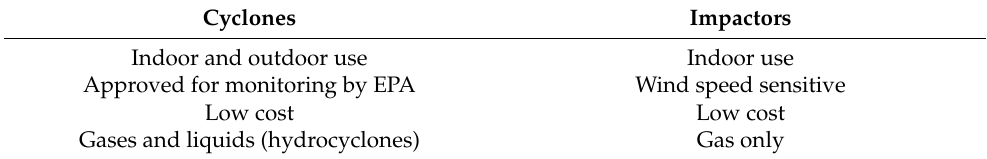
Table 5. Advantages and disadvantages of impactors and cyclones